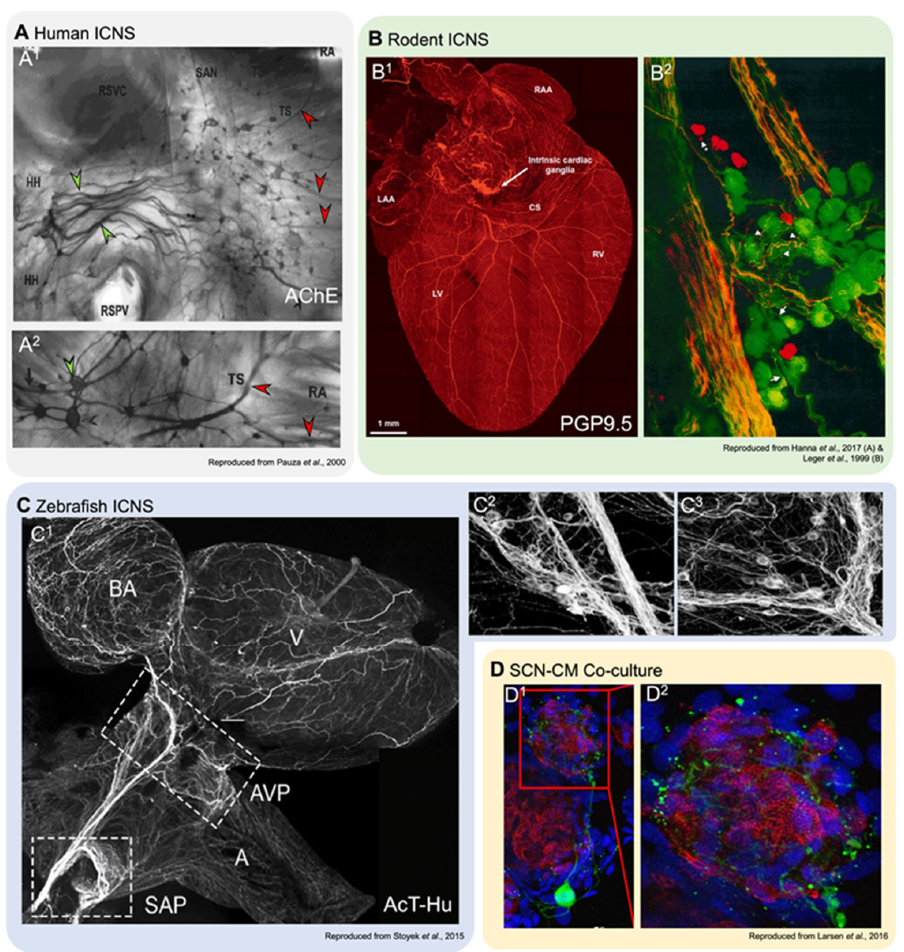
scheme of innervation of the mammalian heart by the cardiac ganglionated plexuses in dorsal ( B ), right lateral ( C ), and superior ( D ) views. Ganglia: DRA, dorsal right atrial; LC, left coronary; LD, left dorsal; MD, middle dorsal; RC, right coronary. Reproduced with permission from [22].